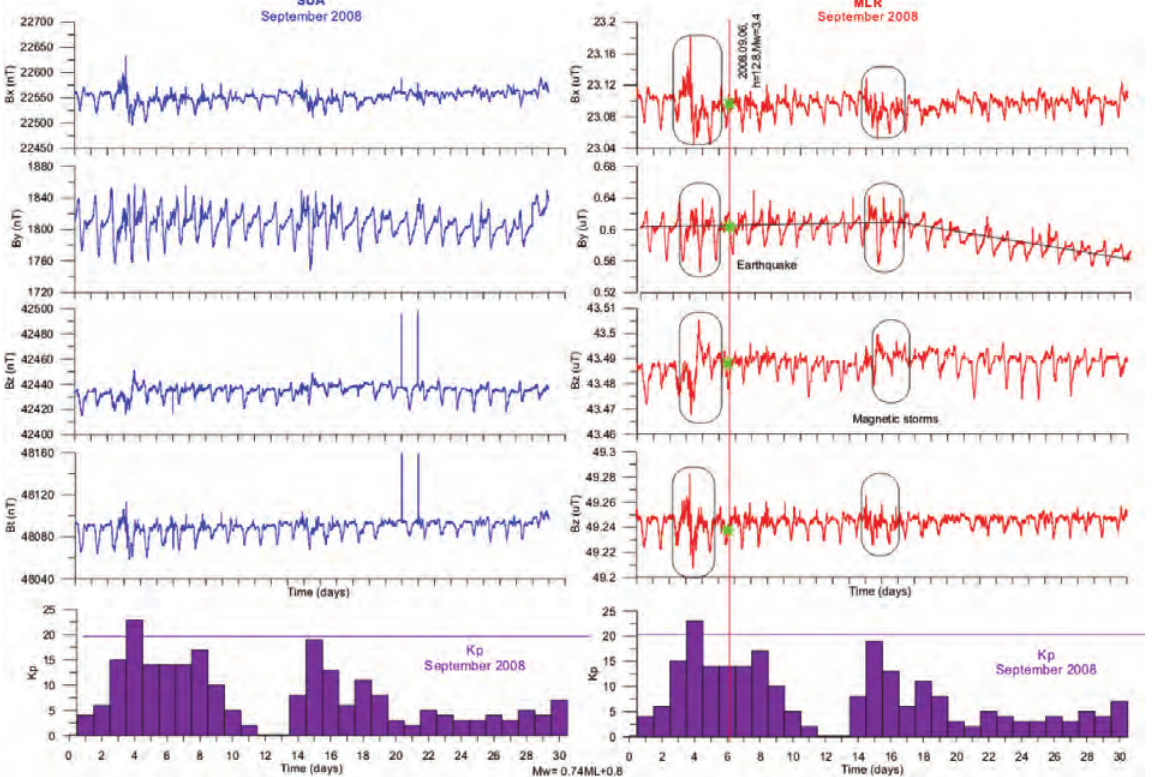
Figure 6. The V-shaped anomaly recorded on the horizontal component By of the MLR Observatory data prior to the Mw = 4.4 (October 2, 2008) crustal Vrancea earthquake.